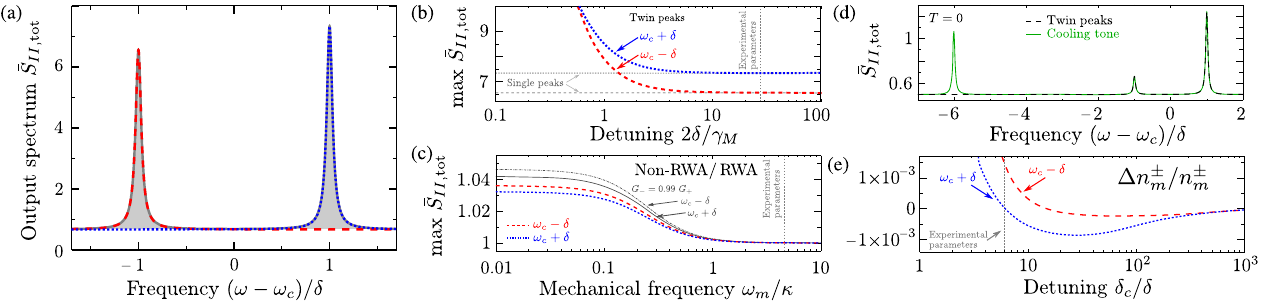
FIG. 4. Effects of asymmetric parameters, the cooling tone, and the next-sideband contributions. The dotted blue (dashed red) lines δ ( − δ ). (a) Symmetrized output spectra as a function of frequency, correspond to the results for the (anti-)Stokes sideband at ω − ω c ¼ þ δ . The dashed for experimental parameters. The solid gray line (area) shows the non-RWA result, which exhibits two peaks at ω ¼ ω c (cid:2) red and dotted blue lines correspond to two independent noise spectral densities, one valid for frequencies close to the anti-Stokes sideband [Eq. (A21a)] and the other one for frequencies close to the Stokes sideband [Eq. (A21b)], which each accurately describe the ∓ δ . (b) Influence of the detuning parameter δ on the output noise. For δ ≫ γ γ resonant peaks at ω − ω , the results from the c ¼ M tot ¼ twin peak spectrum, i.e., from Eq. (A26), coincide with the single-peak approximations (dashed and dotted gray lines). (c) Effect of next- sideband contributions on the noise maximum. The gray lines include a 1% mismatch of the coupling strengths. (d) Symmetrized output spectra for zero-temperature baths with (solid light green line) and without (dashed black line) direct contributions from the cooling tone (experimental parameters). See the text for details. (e) Influence of the detuning δ of the cooling beam on the sidebands. Plotted is c Δ n (cid:2) − n (cid:2) =n (cid:2) n (cid:2) Þ =n (cid:2) m , where n (cid:2) ð n (cid:2) m Þ corresponds to the sideband ’ s weight without (with) direct contributions from the cooling m m ¼ ð m m; 0 m; 0 = ð 2 π Þ ¼ 4 MHz, γ = ð 2 π Þ ¼ 360 Hz, γ = ð 2 π Þ ¼ 10 Hz, δ = ð 2 π Þ ¼ 5 kHz, δ = ð 2 π Þ ¼ 30 kHz, tone. Experimental parameters: ω m M m c κ = ð 2 π Þ ¼ 870 kHz, κ = ð 2 π Þ ¼ 450 kHz, κ = ð 2 π Þ ¼ 155 kHz, and γ = ð 2 π Þ ¼ 100 Hz. For the cavity baths, we assume n th ¼ n th ¼ R L opt R L 0 . 24 , and for the mechanical bath, we assume n th 0 . 3 and n th ¼ 10 c ¼ M